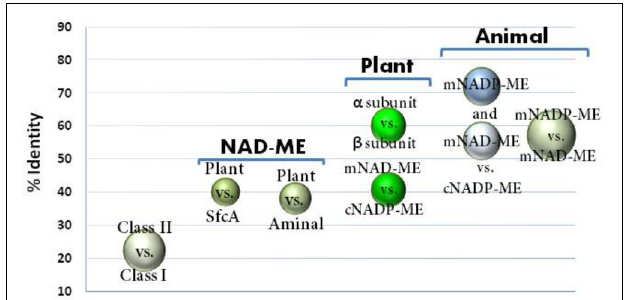
FIGURE 1 | Sequence identity among ME isoforms comparing class I- versus class II-MEs; animal MEs; and relevant group isoforms from plant MEs and NAD-MEs. Circles indicate the identity values (%) obtained by ClustalW alignment among the different ME isoforms indicated in the graph. Circle size is proportional to the standard dispersion. For each comparison, 12 animal MEs and 20 plant ME sequences were used. For class I versus II comparison, ME sequences for 10 eubacteria, MaeB from E. coli , YtsJ from Bacillus subtilis (NC_000964.3), and the accessed protein WP_029552528 from Solfolobus